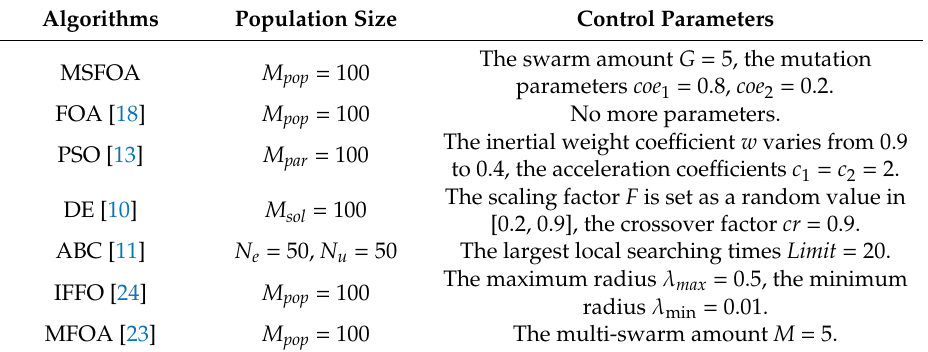
Table 1. The parameters used in experiments of di ff erent